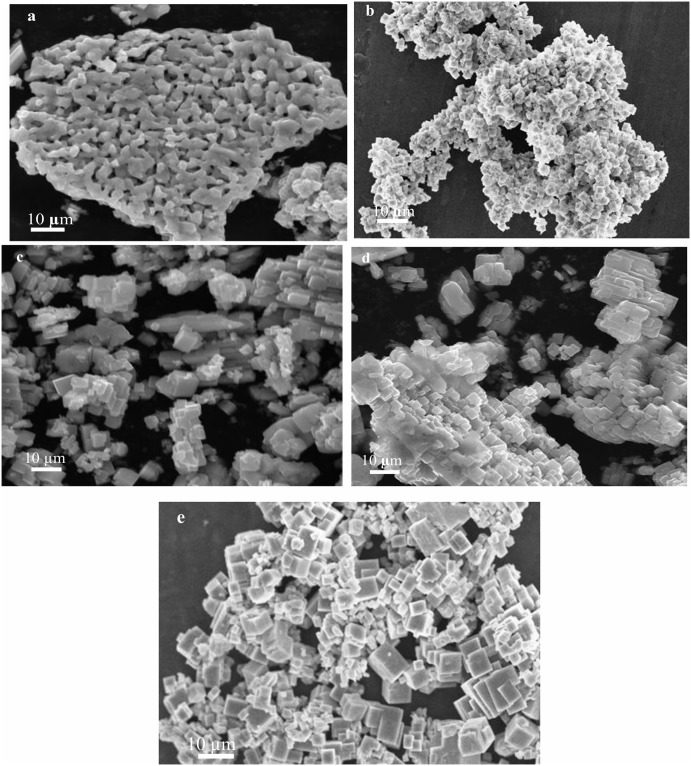
FESEM images of NaNbO3 at different times.(a) 30 min. (b) 1h. (c) 3h. (d) 6h. (e) 12h at 200°C.